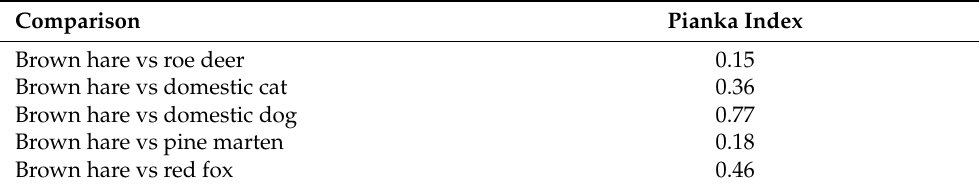
Table 2. Spatial overlap (Pianka index) between the brown hare in natural conditions and its potential predators and